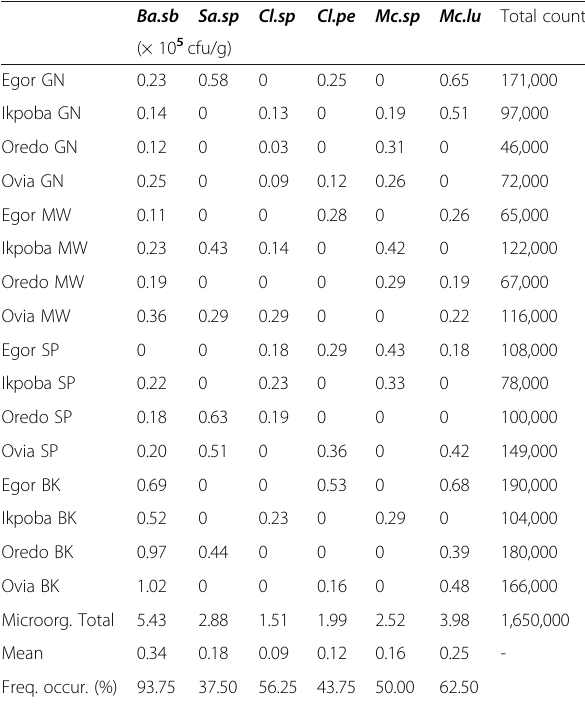
Table 2 Bacterial count in spent crude oil-polluted sites within Benin